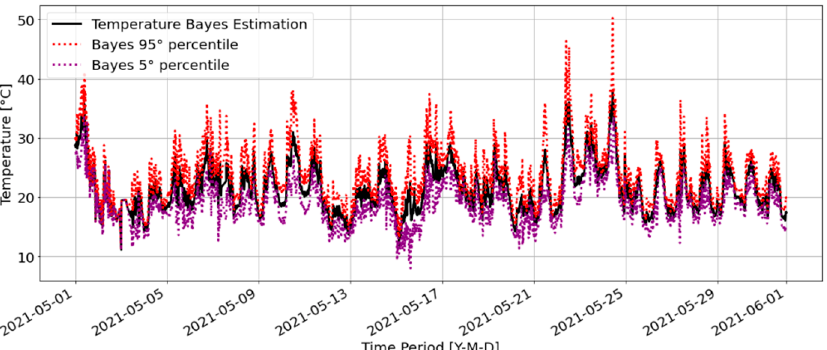
Figure 8 . Zoom Bayes temperature trend and confidence range for a specific period: Bayes equation (black line).